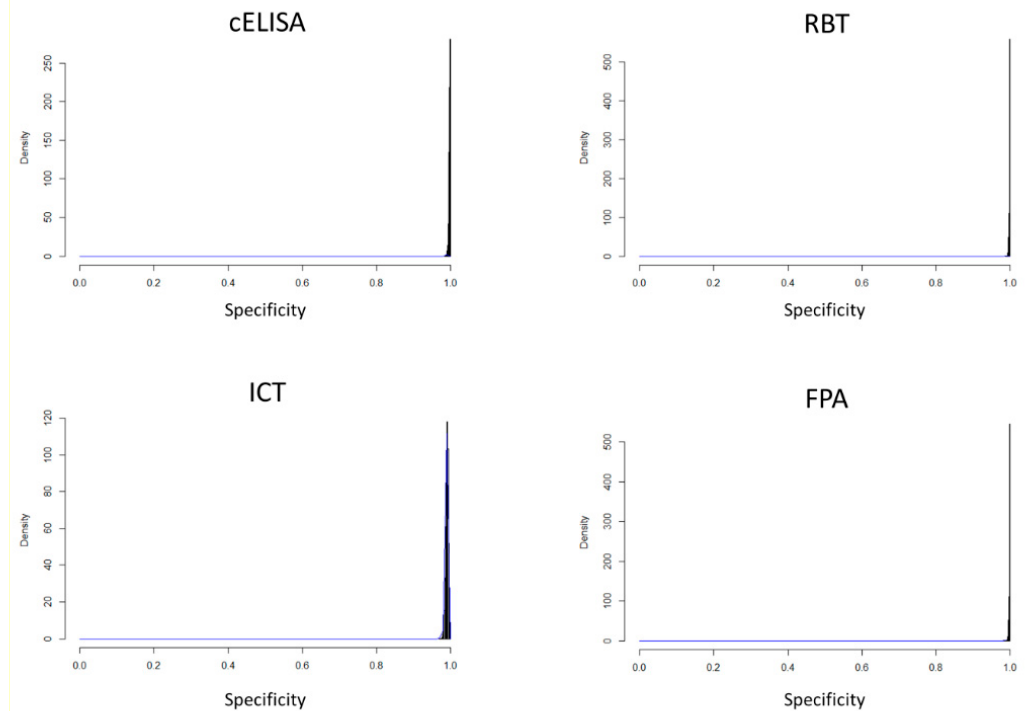
Figure 2. Estimated distributions of specificity values for c-ELISA, Rose Bengal Test (RBT), Immunochromatographic Test (ICT) and Fluorescence Polarization Assay